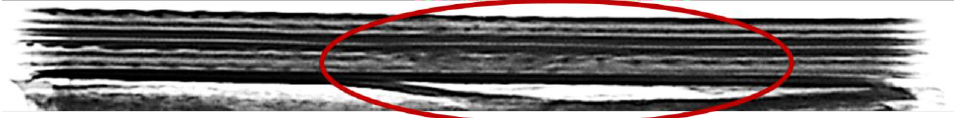
Figure 15. A particular of radiographic inspection for Type V specimen subjected to an impact of 35 J. Skin damage is highlighted by the red circle.